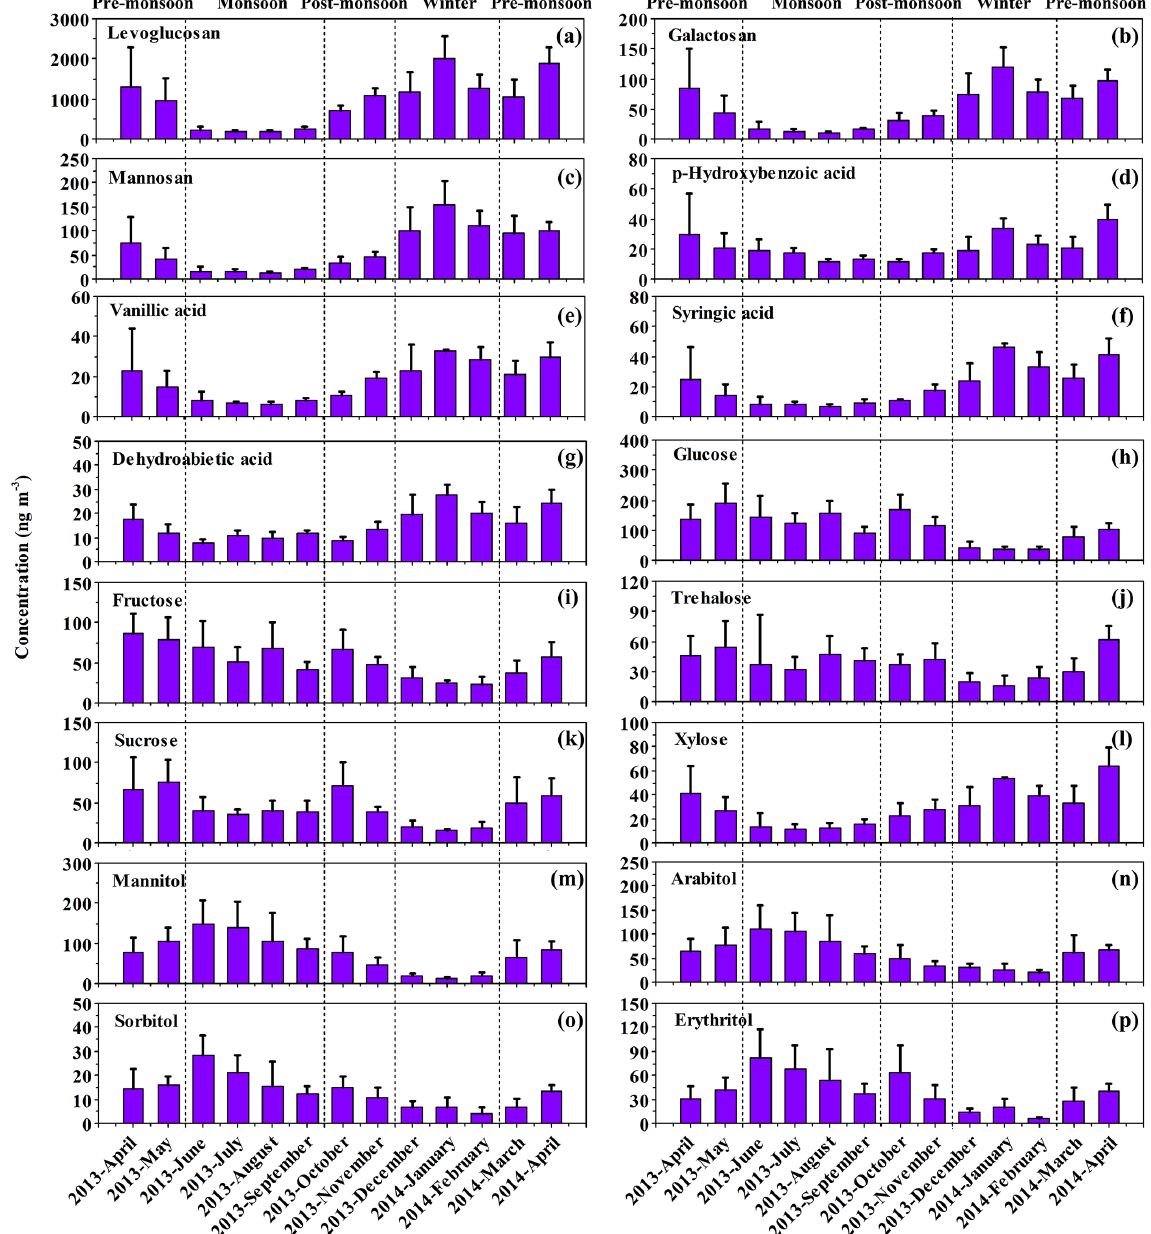
Figure 3. Monthly variations in biomass burning tracers, monosaccharides, and sugar alcohols at the Bode site, Kathmandu Valley, during April 2013–April 2014.